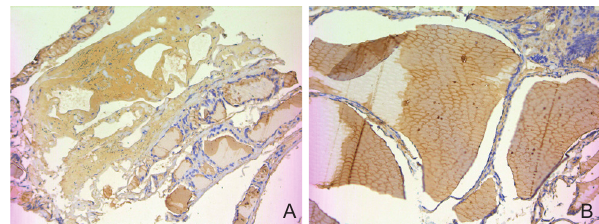
Figure 3 Expressions of HSP70 in central zones of nodular goiter before and shortly after thermal ablation (×200). (A) week expressions of HSP70 in the marginal zone before ablation; (B) week expressions of HSP70 in the marginal zone shortly after ablation.